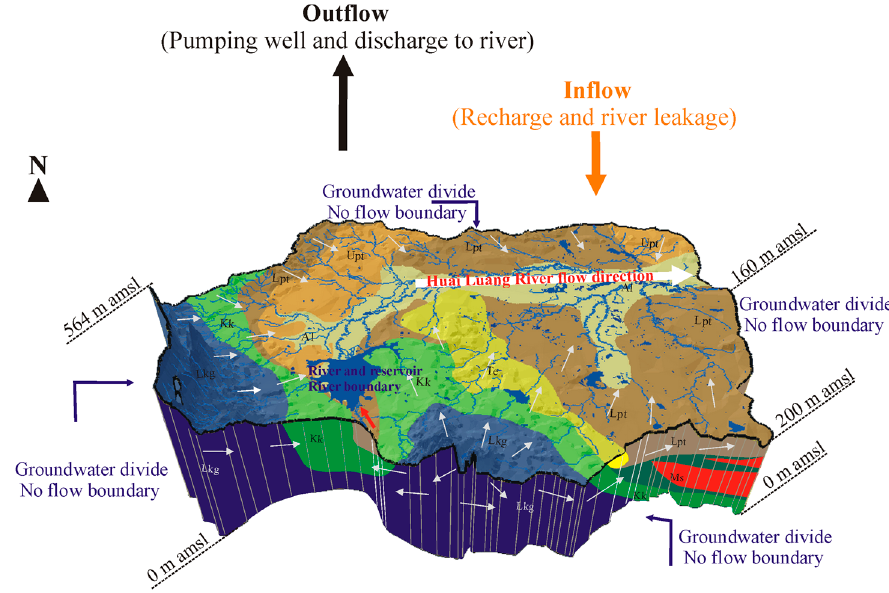
Figure 9. Boundary conditions of the hydrogeological conceptual model of CHLB aquifers system (model A).